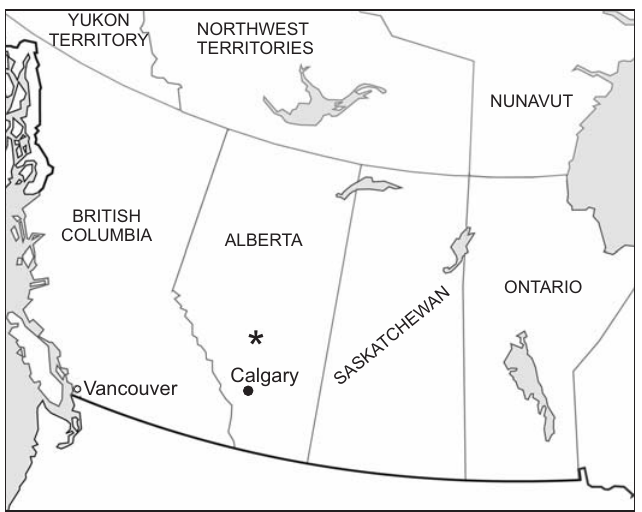
Fig. 1. Map of Western Canada showing type locality (asterisked) of